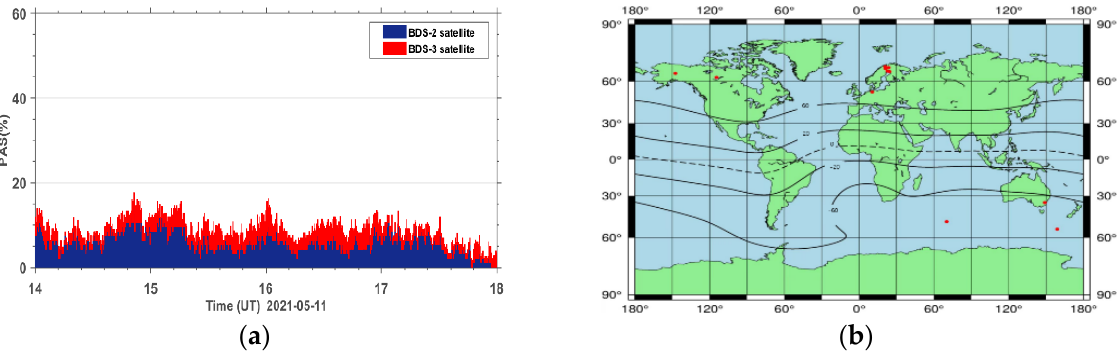
Figure 14. ( a ) The PAS index during the period of 14–18 h on 11 May 2021 and ( b ) the global distribution map of BDS sites affected by ionospheric irregularities in the geomagnetic auroral regions.